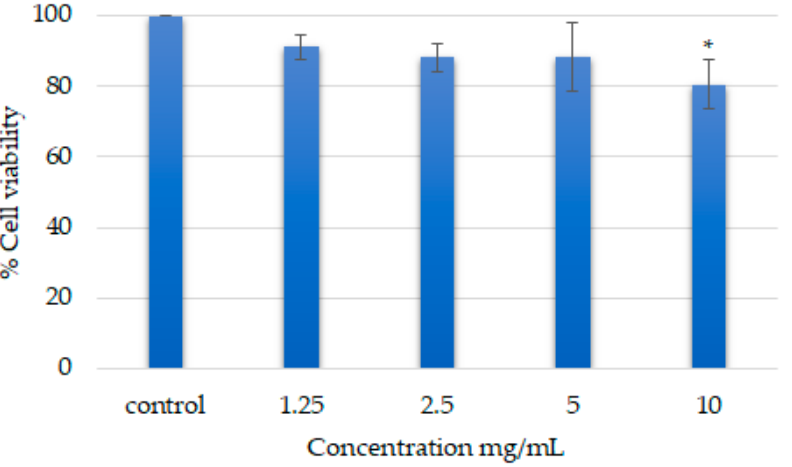
Figure 5. Concentration-dependent cytotoxicity test results for the optimized formulation (F3). Data presented as mean ± SD; n = 4; * indicates significant change in viability of the cells when compared to the control group ( p < 0.05).